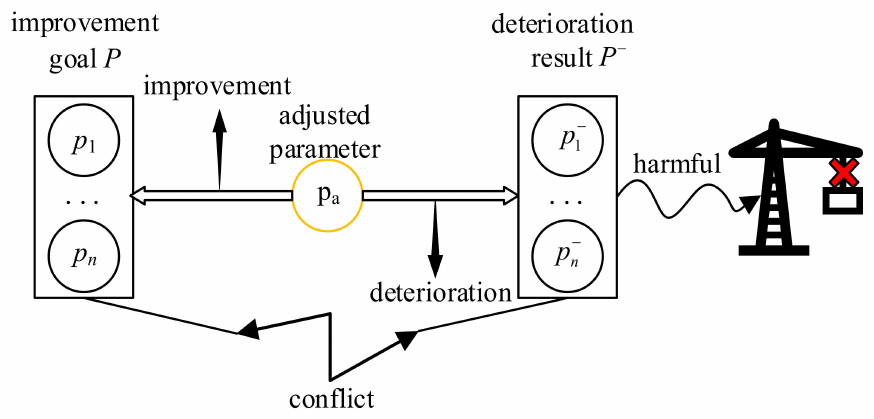
Figure 11. System conflicts determination.